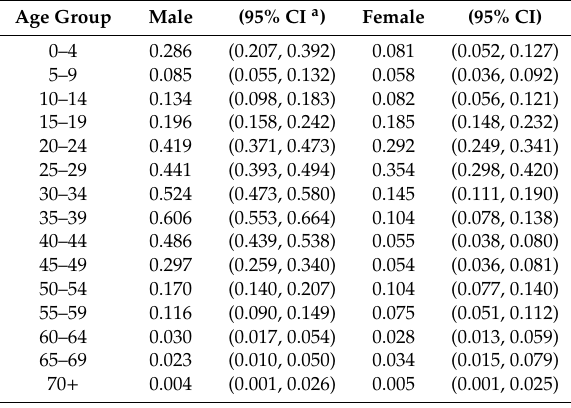
Table 1. Relative susceptibility, interpreted as being proportional to the per contact probability of transmission, depending on age group and